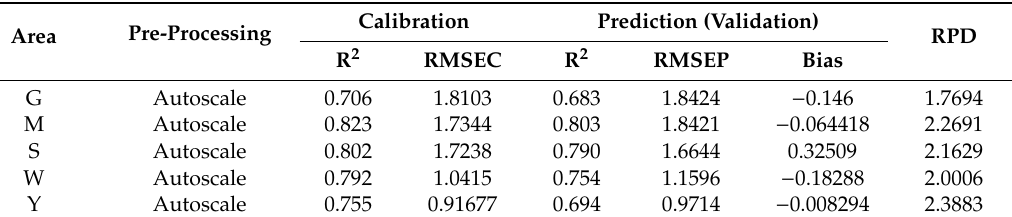
Table 9. Best results of each area with second derivative data and their preprocessing at a spectral sampling range of 729–975 nm using support vector machine regression (SVM-R).